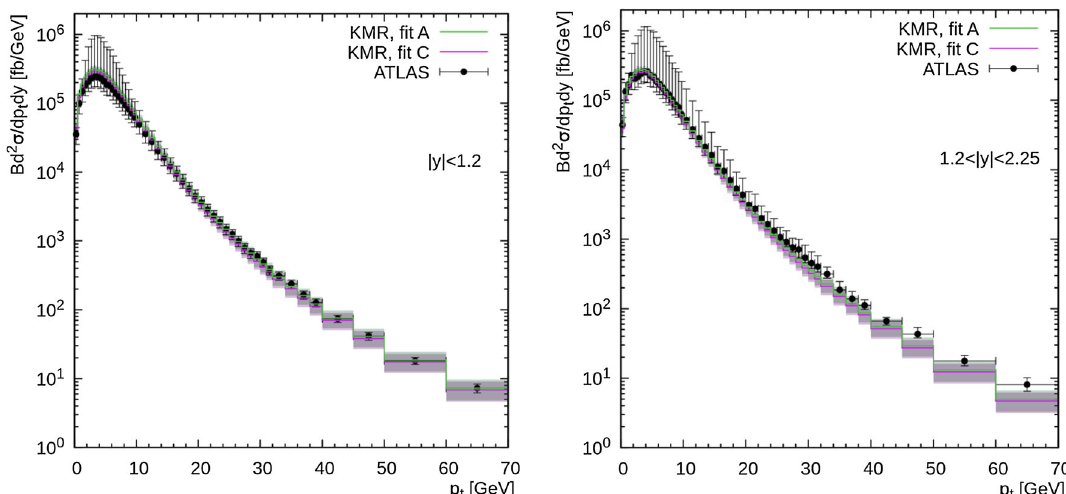
Fig. 6 Transverse momentum distribution of the inclusive ϒ( 1 S ) pro- √ s = 7 TeV in the different rapidity regions. The duction calculated at green and purple histograms correspond to the “fit A” and “fit C” pre-